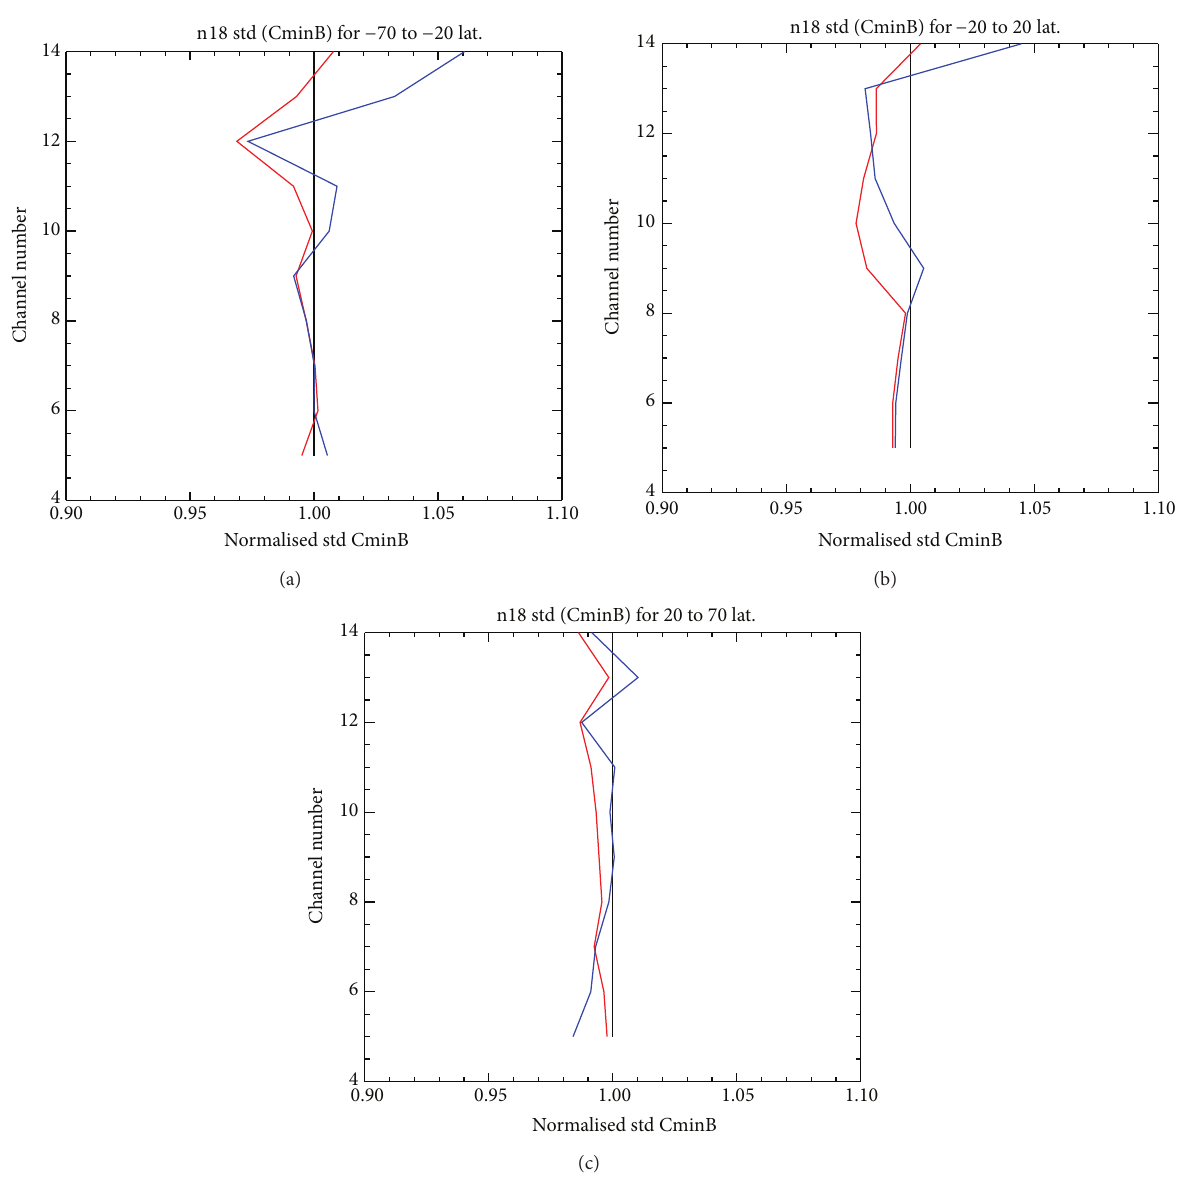
Figure 10: Standard deviation of corrected brightness temperature difference for NOAA-18 AMSU temperature sounding channels, normalised with respect to the control experiment (black). Southern Hemisphere (a), tropics (b), and Northern Hemisphere (c). Red line is operational thinning; blue line shows reduced thinning (28 June–28 August